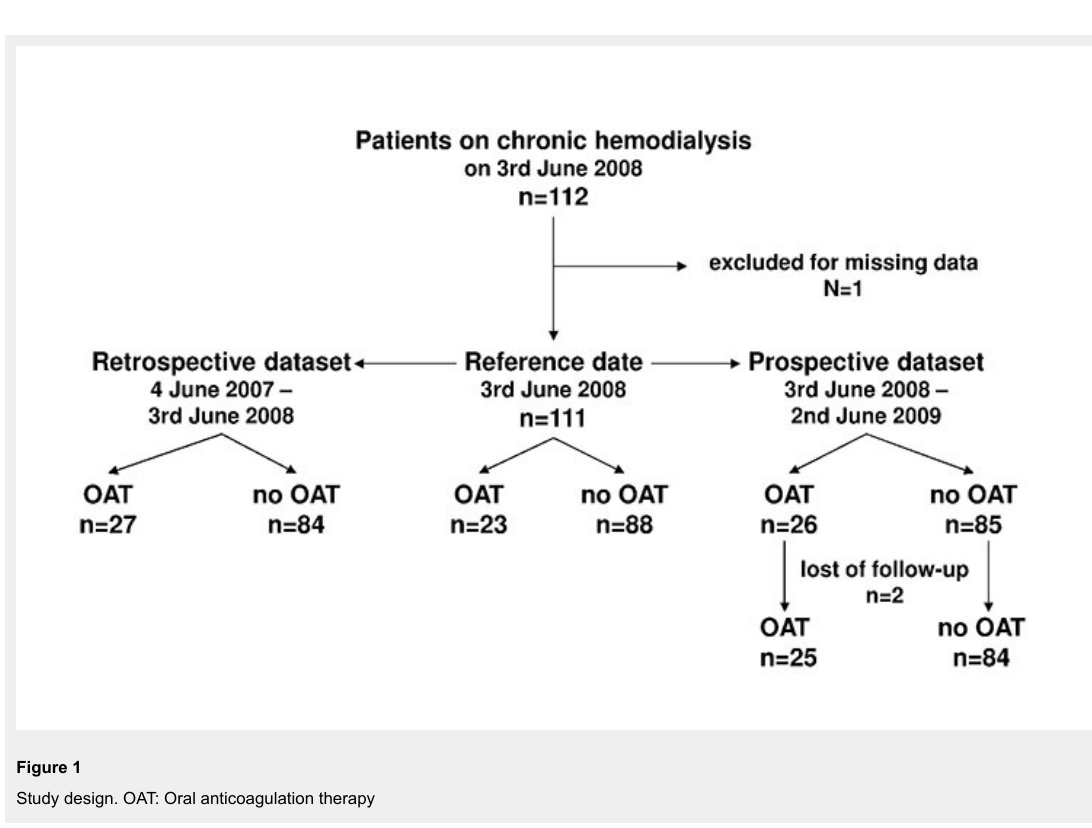
Study design. OAT: Oral anticoagulation therapy